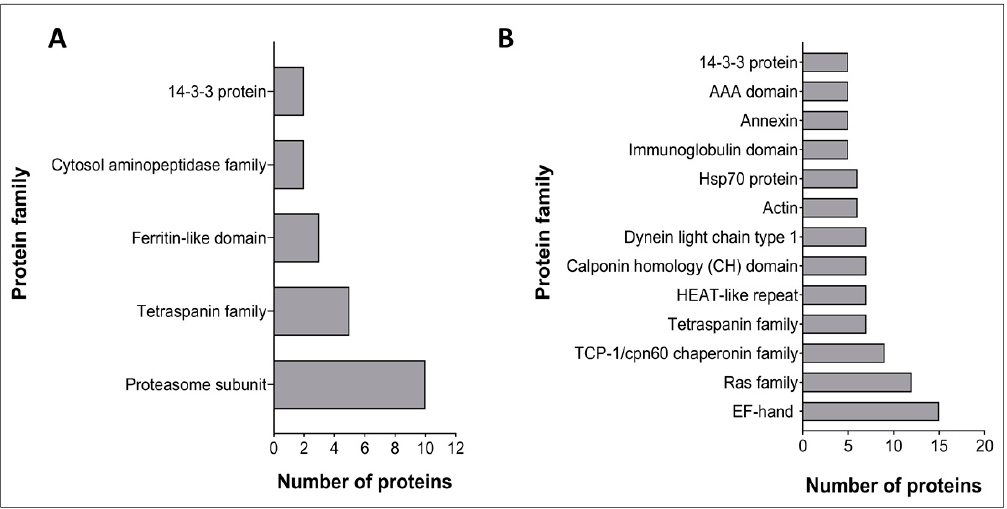
Figure 2. Pfam analysis of the most abundant Schistosoma haematobium vesicle proteins. The X-axis represents the number of proteins containing at least one of those domains. ( A ) 120k pellet vesicles ( B ) 15k pellet